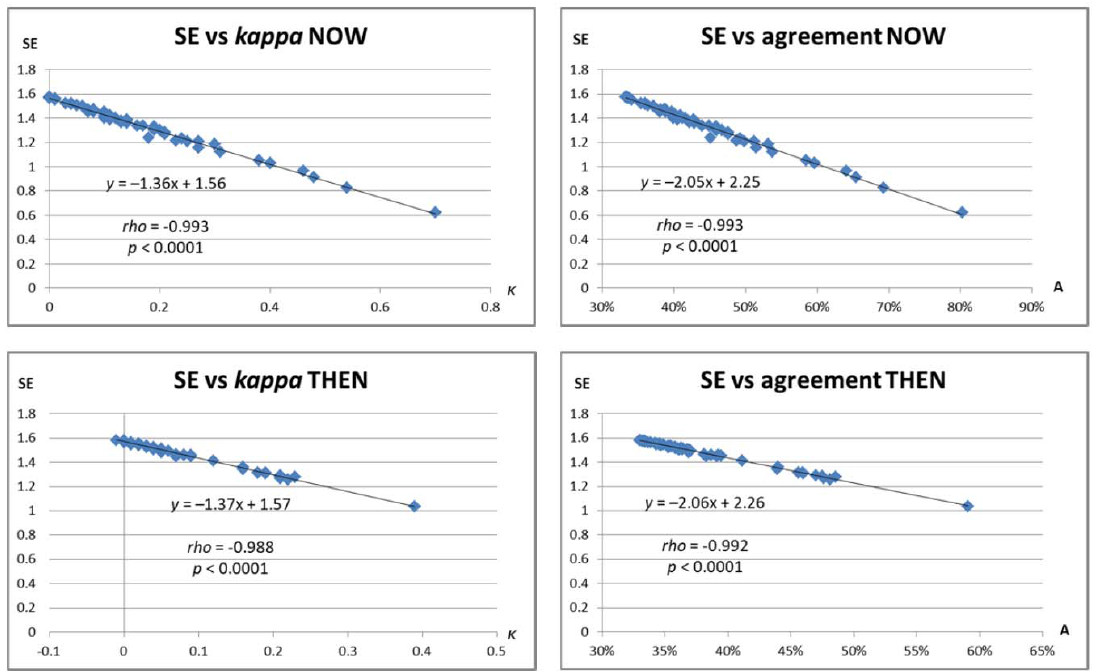
Figure A1. Scatter plots of Shannon entropy (SE) vs. free-marginal kappa and overall agreement for the 60 main survey questions.